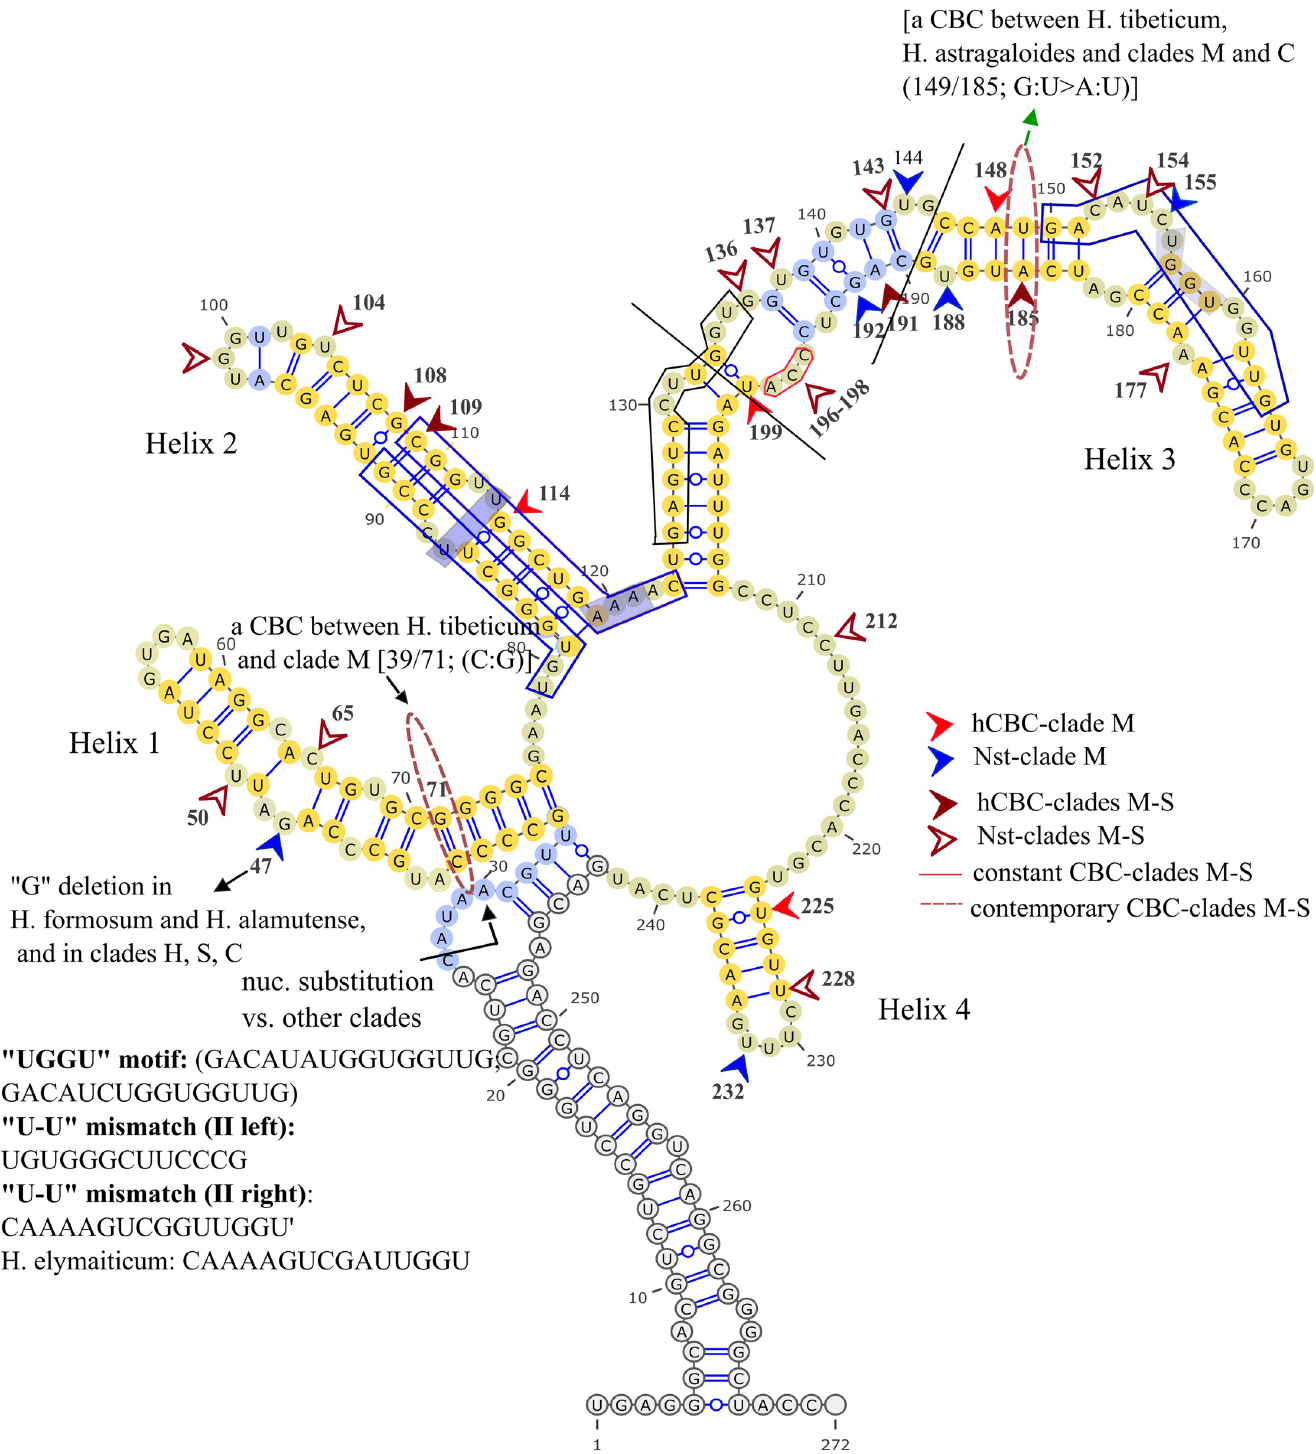
Fig 9. ITS2 Consensus secondary structure of H . sect. Multicaulia Subsect. Multicaulia (clade M). Yellow flashes 100% conserved regions in the section.